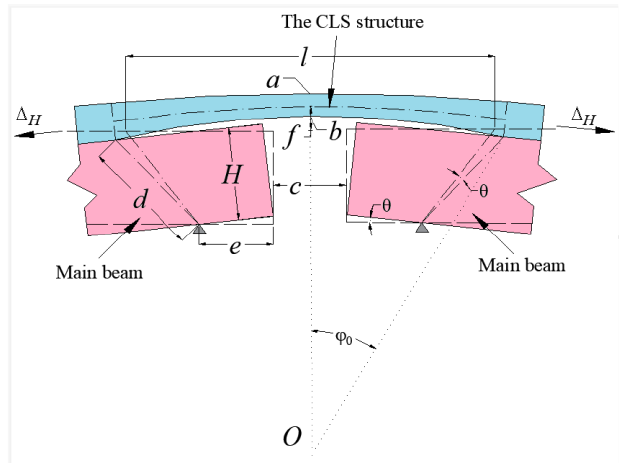
Figure 4. Deformation of the beam end structure.